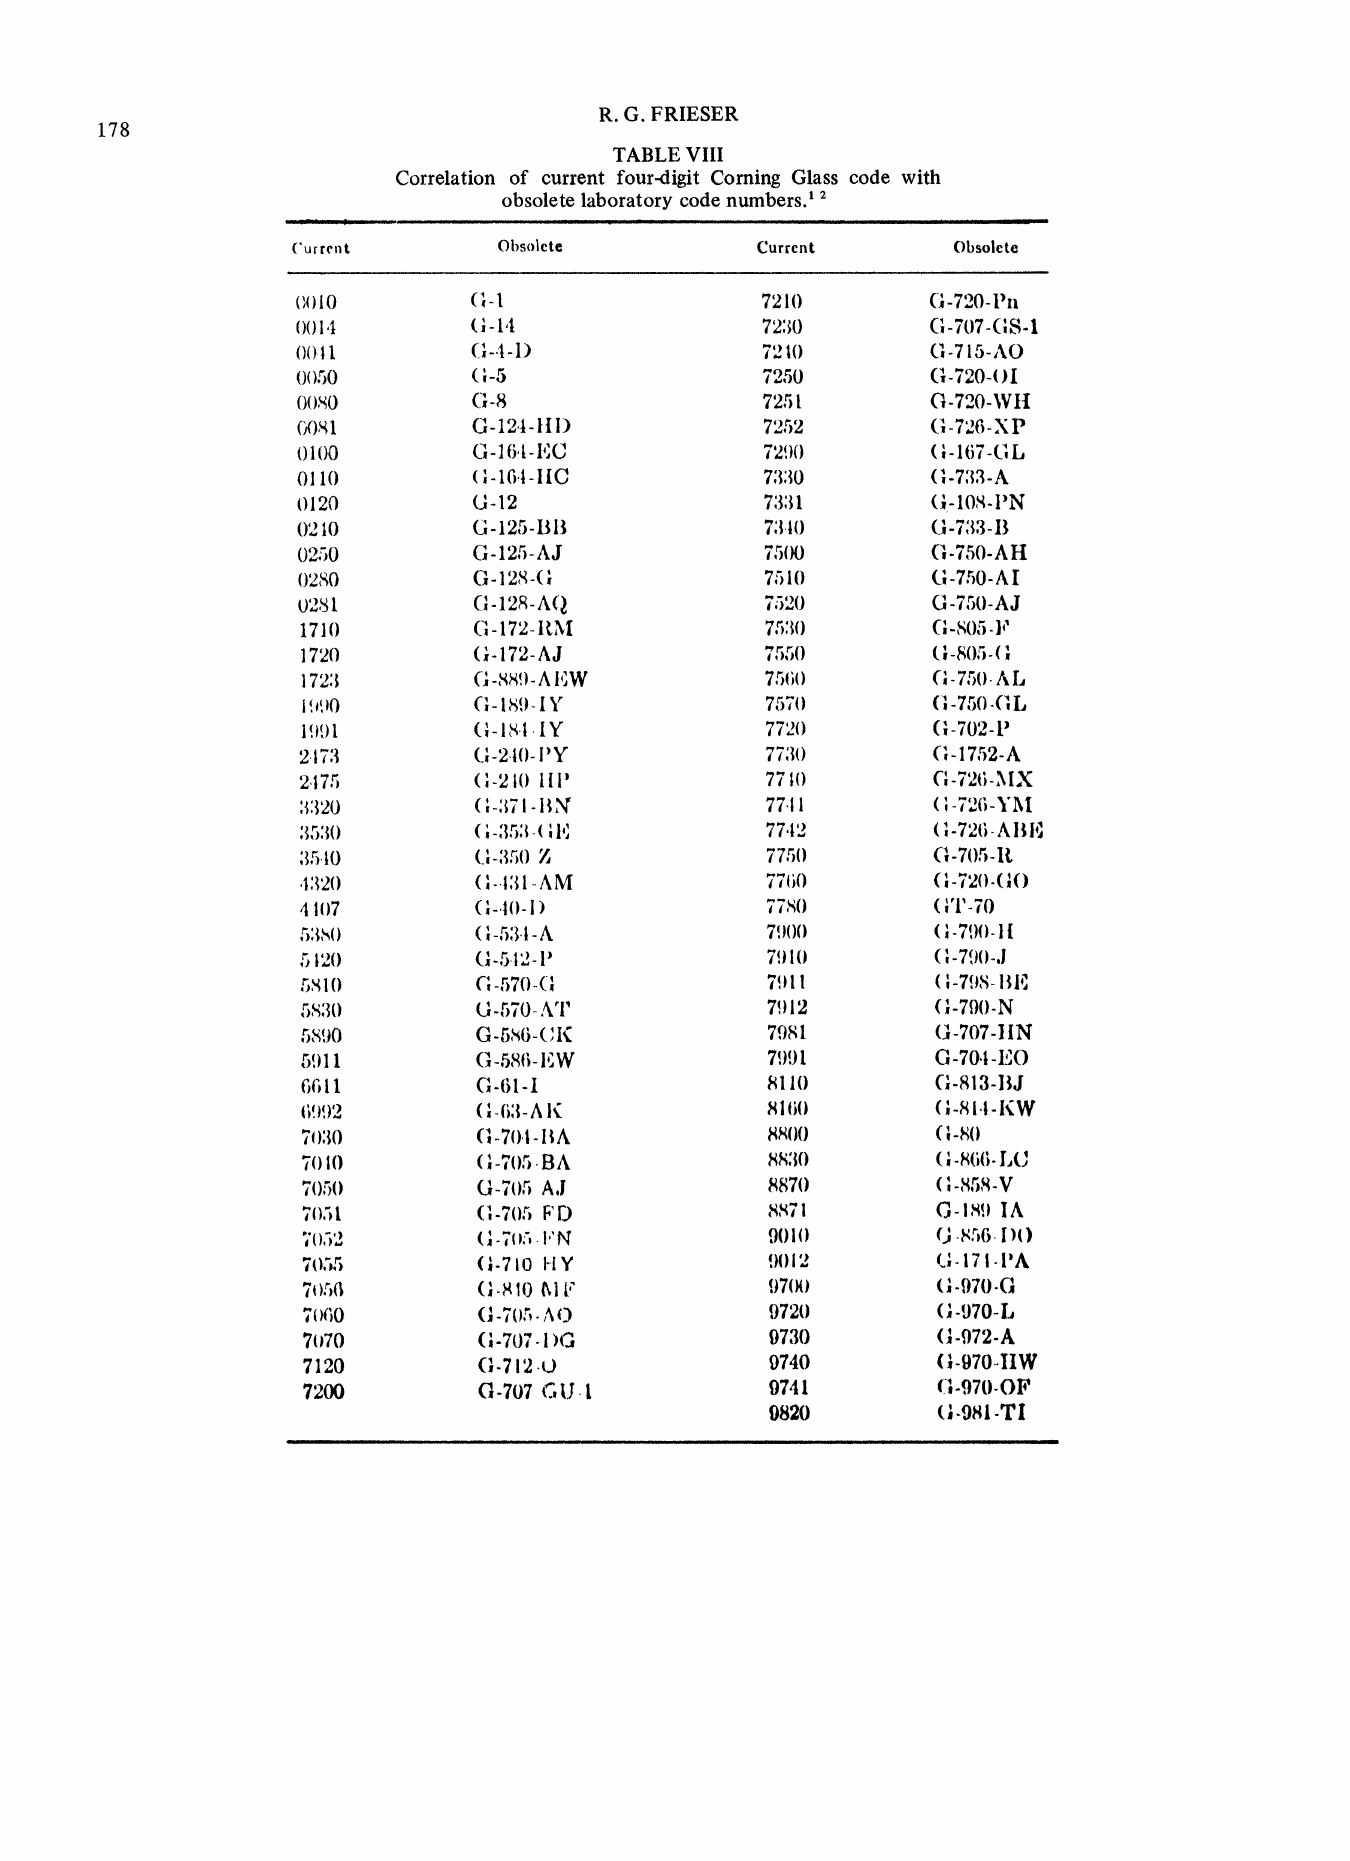
TABLE VIII Correlation of current four-digit Corning Glass code with obsolete laboratory code